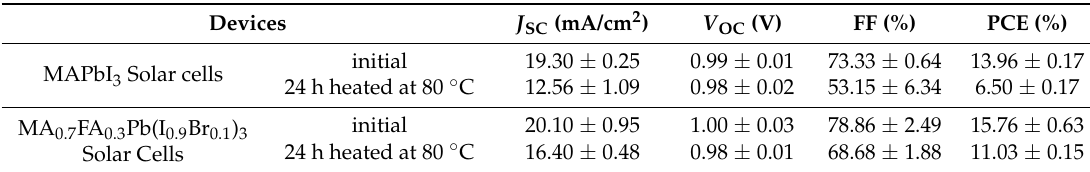
Table 2. Photovoltaic parameters of MAPbI 3 and MA 0.7 FA 0.3 Pb(I 0.9 Br 0.1 ) 3 PSCs before and after 24 h heated at 80 ◦ C.